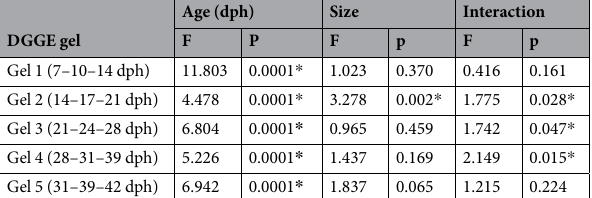
Table 1. Results from two-way PERMANOVA analysis of microbiota community composition profiles of larval in the 5 DGGE gels using age (dph) and size (categorized as small or large) as the main effects. F- and p-values are given for main effects and for the interaction effect between age and size. * Indicate significant